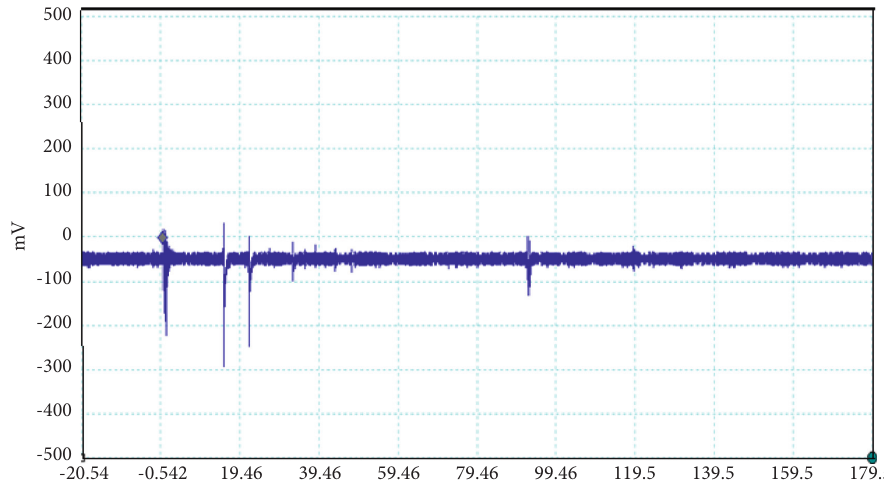
Figure 4: Example of the unusual lightning signal of window size 200ms, which is recorded as a flash number 20150416-0029 in Kathmandu,